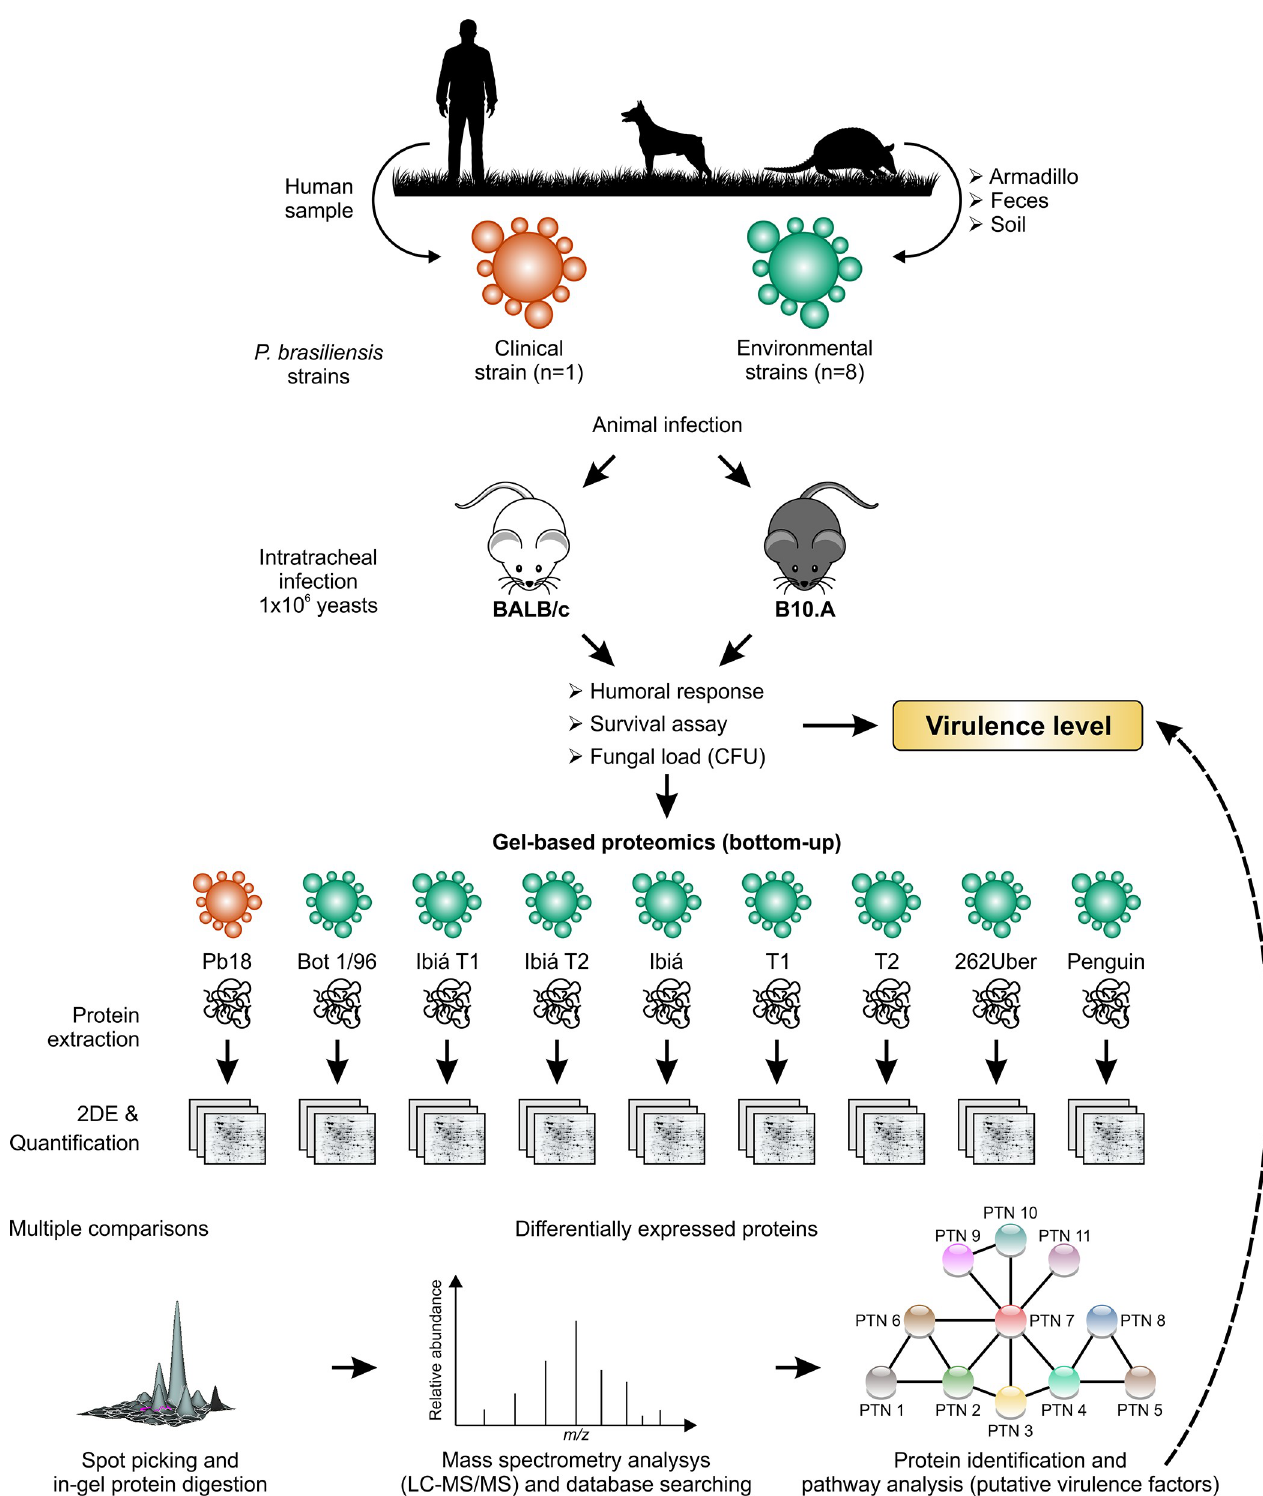
Fig 1. Schematic depicting a two-dimensional (2D) proteomic approach used in this study in an attempt to identify possible virulence factors of Paracoccidioides spp. Isolates were selected according to their source (clinical and environmental) and submitted to virulence assays in BALB/c and B10.A mice. Afterwards, the yeasts were recovered, proteins were extracted and then resolved by 2D gel electrophoresis. Proteins were deemed to have differential abundance levels if their spot volumes were changed at least twofold compared to the normalized spot volume, and based on statistical significance. Proteins